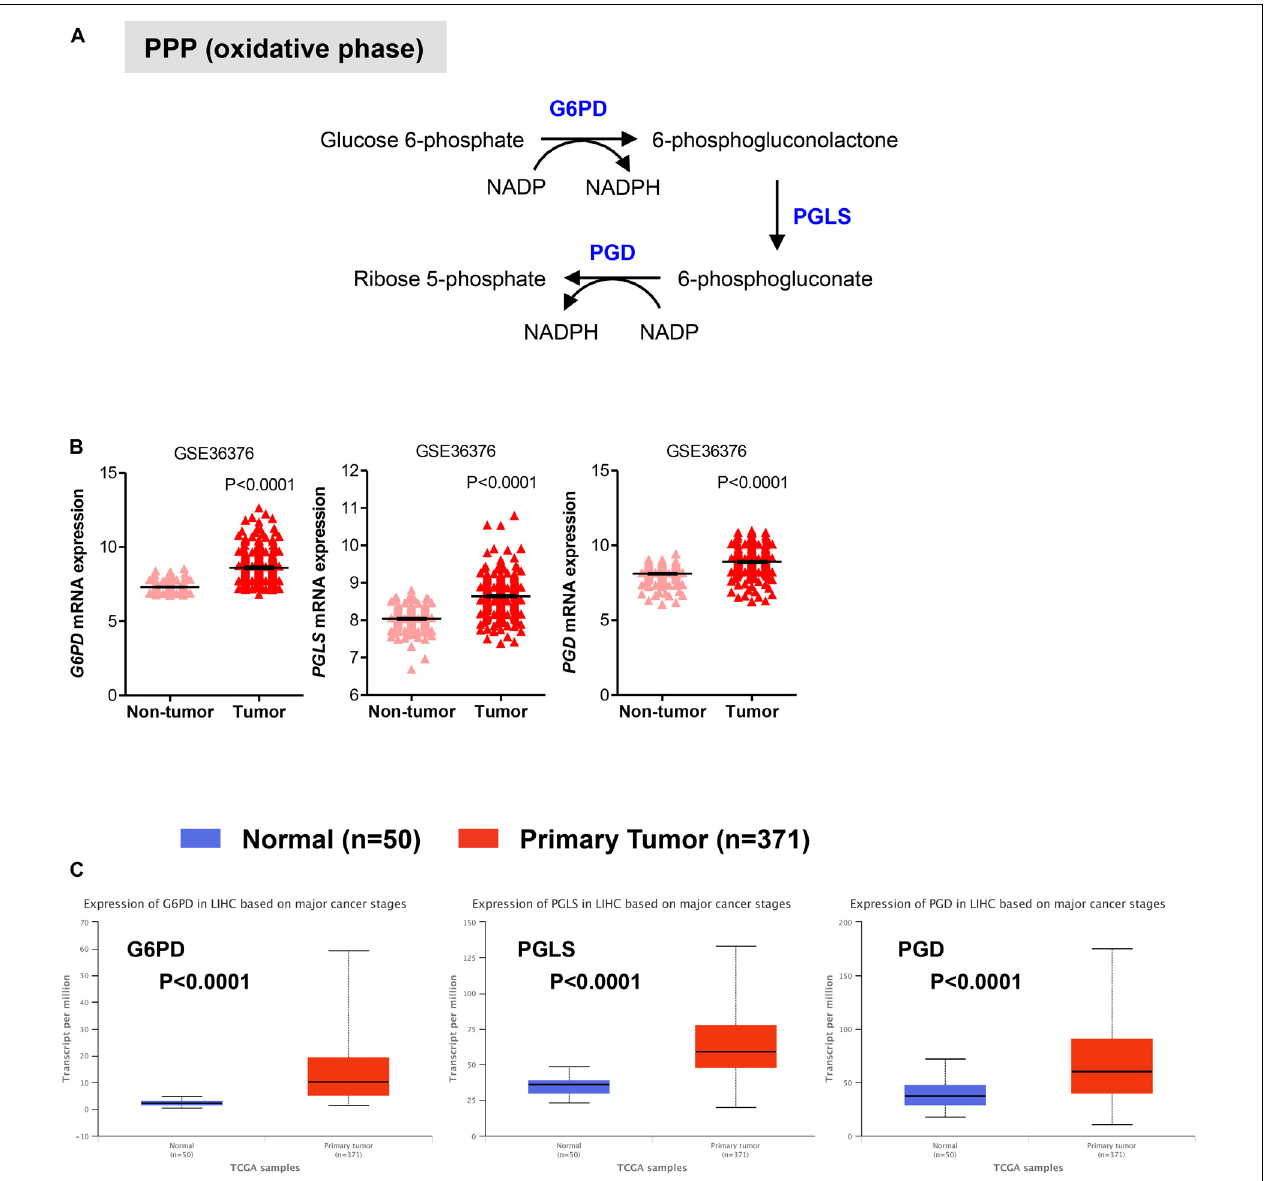
FIGURE 2 | Expression of genes in pentose phosphate pathway (PPP). (A) Diagram of the oxidative phase of the PPP. Abbreviations of the enzymes are as follows: glucose-6-phosphate dehydrogenase (G6PD), 6-phosphogluconolactonase (PGLS), 6-phosphogluconate dehydrogenase (PGD). Activation of the two dehydrogenase enzymes, G6PD – the rate-limiting enzyme – and PGD, results in the production of NADPH, H+ ions, and ribose 5-phosphate. (B,C) Gene expression analyses showing enhanced expression of G6PD, PGLS, and PGD in primary HCC tumor samples compared to either adjacent non-tumor samples in GSE36376 data set (B) or normal liver tissues in TGA-LIHC data set (C) , respectively. P -values were calculated by nonparametric Mann–Whitney tests in (A) or by t -test (B)